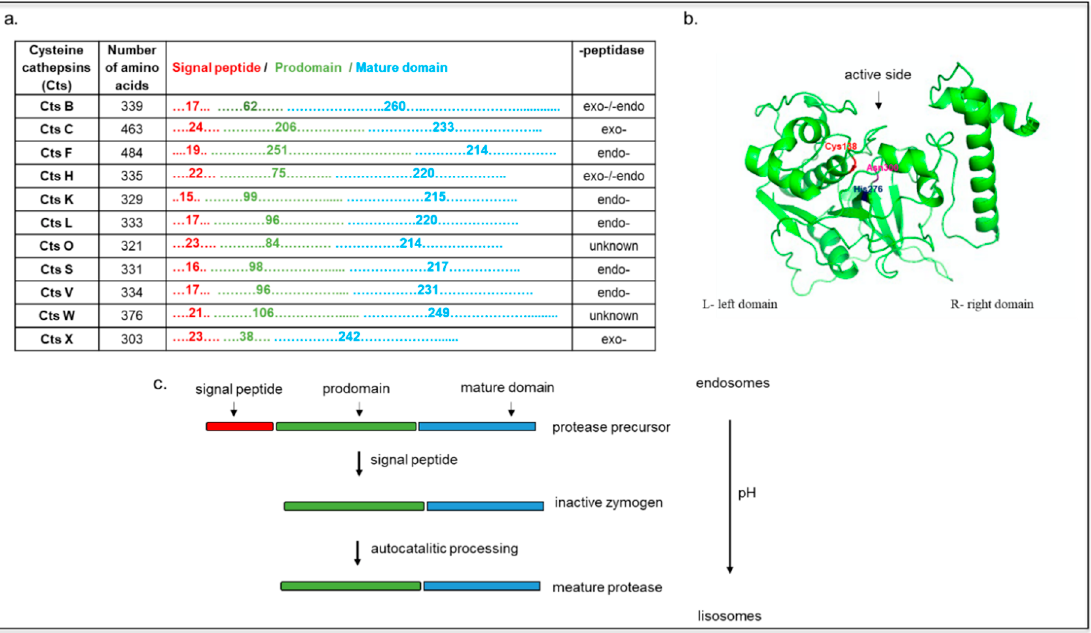
Figure 1. ( a ) Cysteine cathepsins (Cts) functional sequences. Representation of Cts according to their number of amino acids, length of domains (signal peptide, prodomain, and mature domain), and peptidase property. ( b ) Structure of cathepsin L. Cys138–His276–Asn300 triad at the active side is colored (model created with SWISS-MODEL and PyMOL). ( c ) Scheme Cts maturation as the function of endolysosomal pH. The mannose-6-phosphate pathway favors Cts delivery to endosomes, where they are eventually sorted into the lysosomes. At acidic pH, the pro-peptide is removed, and an active single-chain intermediate is generated. The removal of propeptide is mediated by other proteases (independent of autocatalytic activity). The single-chain molecule is further processed into mature two-chain form comprising an amino-terminal light chain and a carboxyl-terminal heavy